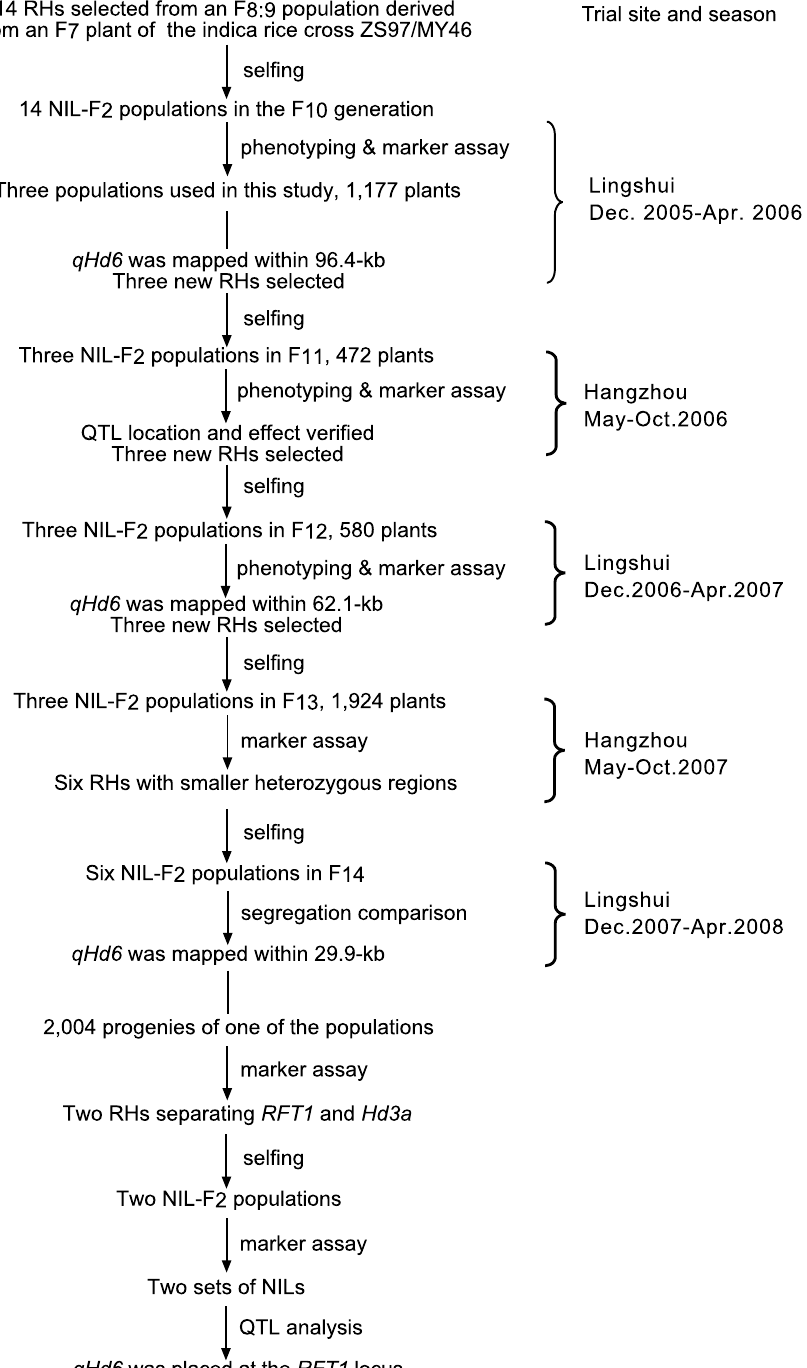
Figure 1. The procedure used for fine-mapping qHd6 in this study. A three-step procedure, selecting RHs overlapped in the candidate QTL region – constructing NIL-F 2 populations – performing QTL analysis, was repeated until the QTL was placed at the RFT1 locus. NIL, near isogenic line. RH, residual